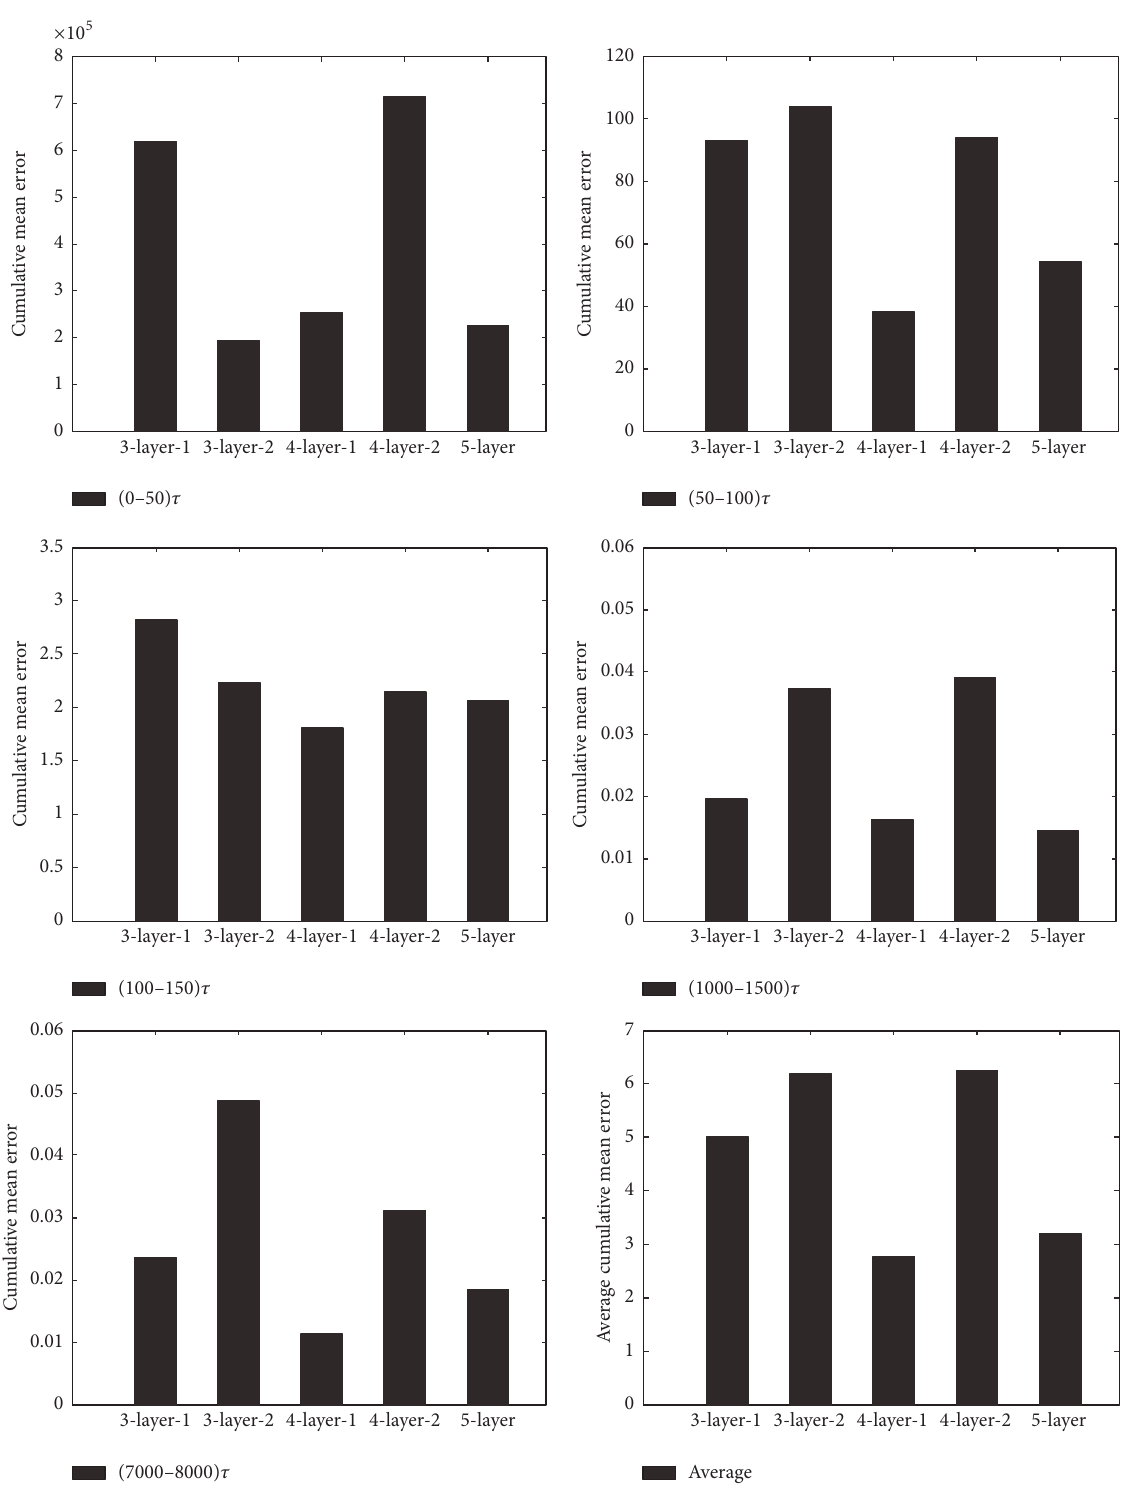
Figure 10: Cumulative mean errors during five time intervals (0–50) 𝜏 , (50–100) 𝜏 , (100–150) 𝜏 , (1000–1500) 𝜏 , and (7000–8000) 𝜏 and final average